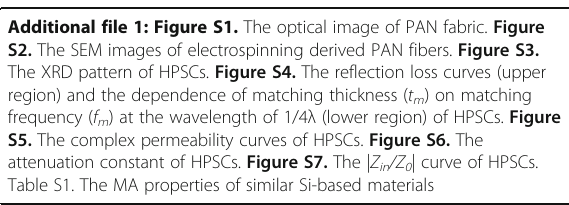
Additional file 1: Figure S1. The optical image of PAN fabric. Figure S2. The SEM images of electrospinning derived PAN fibers. Figure S3. The XRD pattern of HPSCs. Figure S4. The reflection loss curves (upper region) and the dependence of matching thickness ( t m ) on matching frequency ( f m ) at the wavelength of 1/4 λ (lower region) of HPSCs. Figure S5. The complex permeability curves of HPSCs. Figure S6.